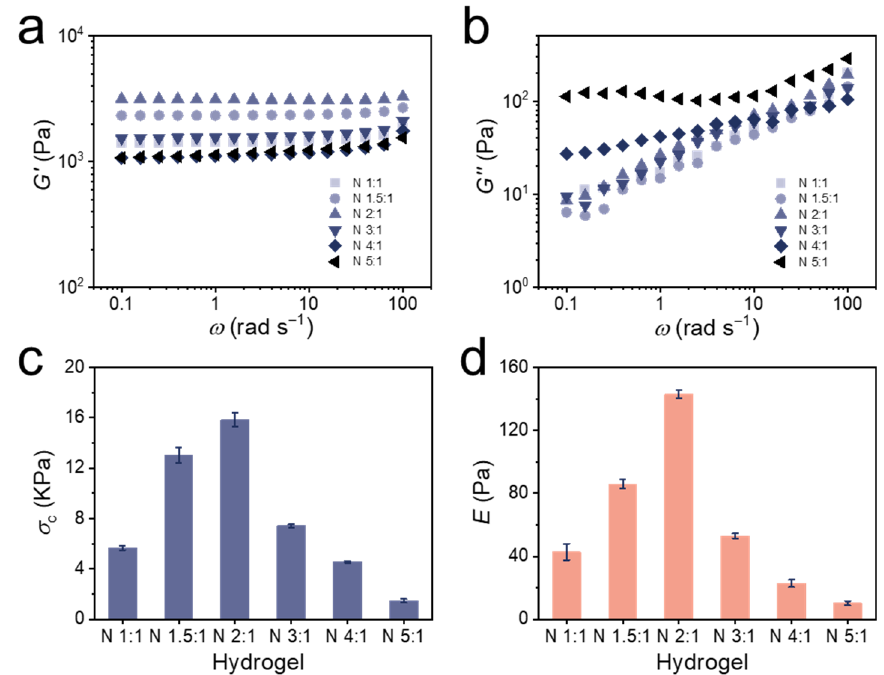
Figure 3. Frequency dependence of ( a ) storage modulus ( G ′ ) and ( b ) loss modulus ( G ″ ) for the bulk PNiPAAm hydrogel (from N 1:1 to N 5:1 hydrogel) at a fixed temperature ( T = 25 °C) and strain ( γ = 1%). ( c ) Compression strengths at 50% strain and ( d ) elastic moduli ( E ) of bulk PNiPAAm hydrogels (from N 1:1 to N 5:1 hydrogel). At least three bulk hydrogels were tested for each experimental point to obtain reliable data.